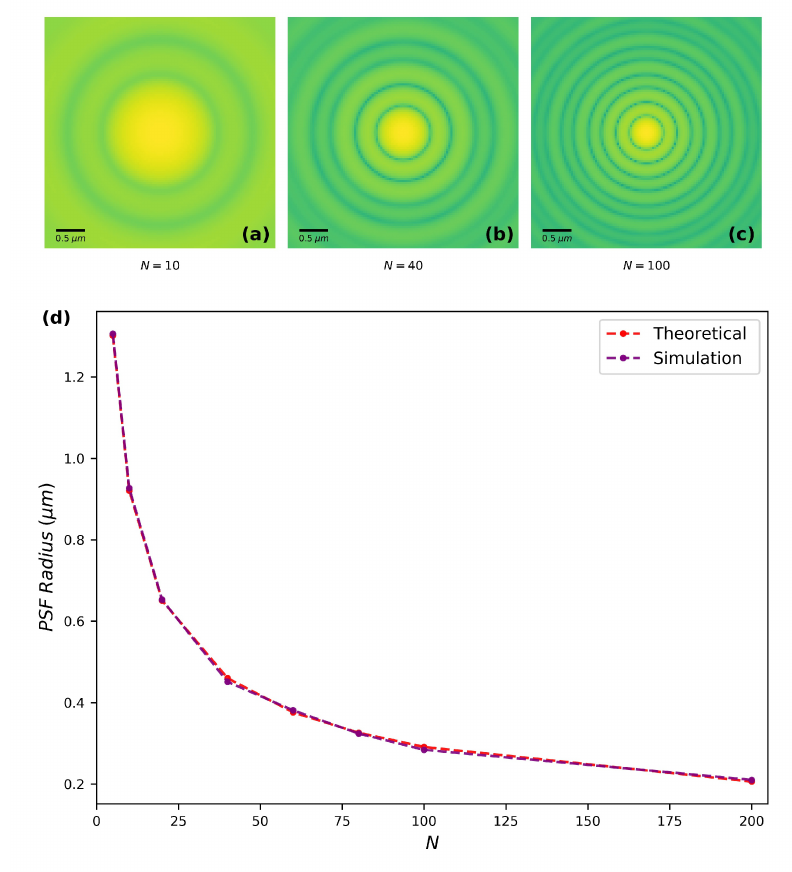
Figure 3. ( a – c ) False color images of simulated Point Spread Function (PSF) on a logarithmic scale, when the number of zones N equals to 10, 40, and 100. ( d ) Theoretical and simulated PSF spot radius versus